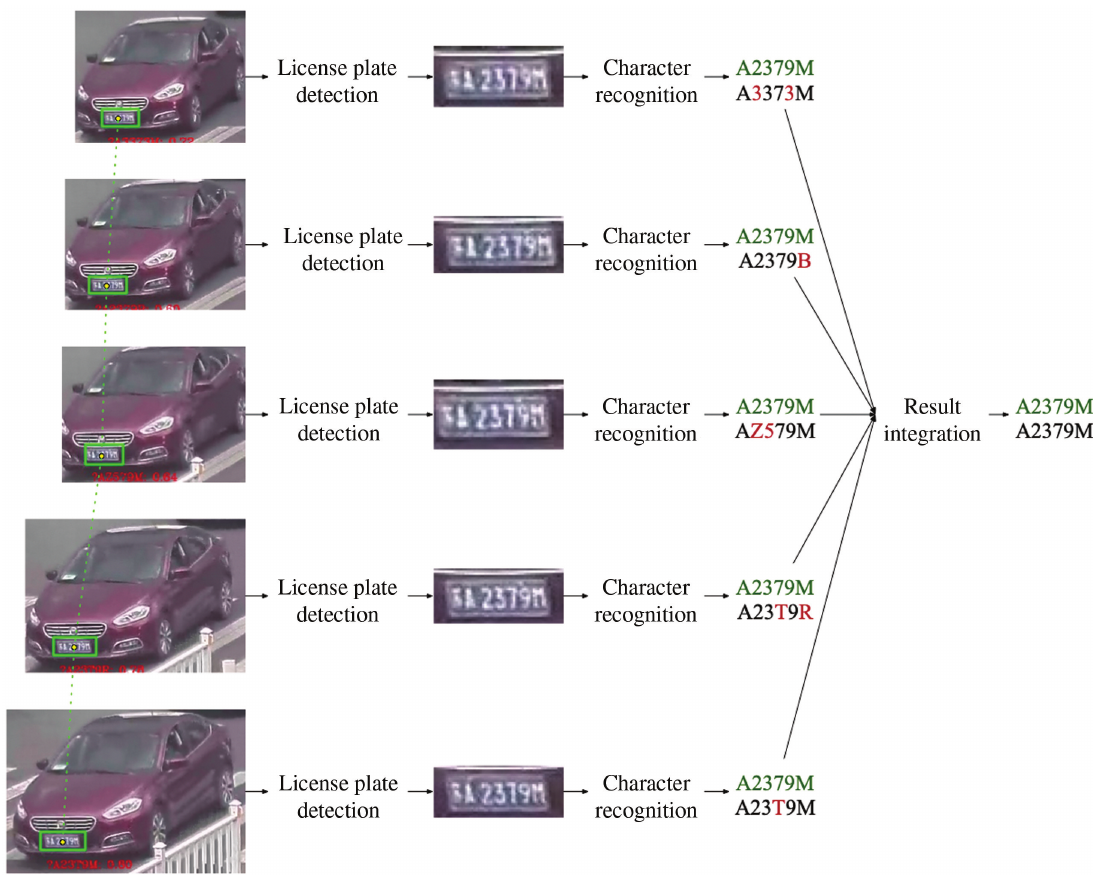
Figure 1: Framework of the LPR System Based on Vehicle Tracking and Result